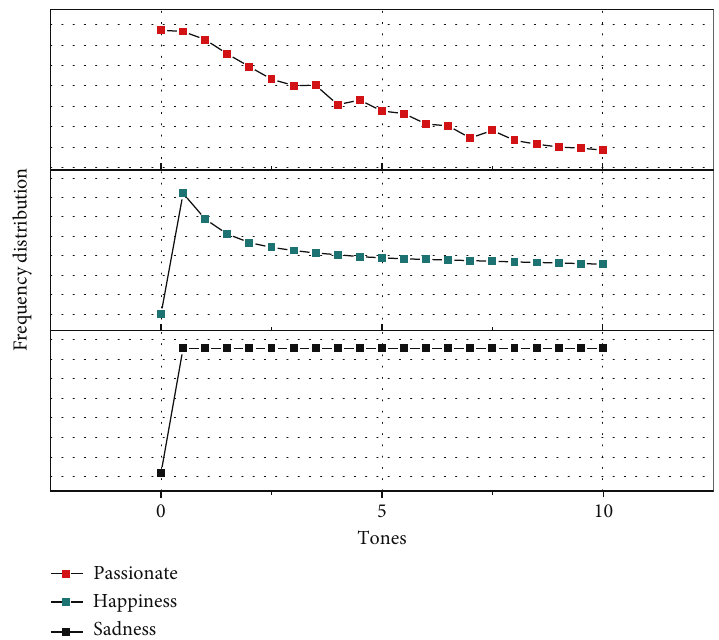
Figure 7: Frequency distribution of descriptive measures.